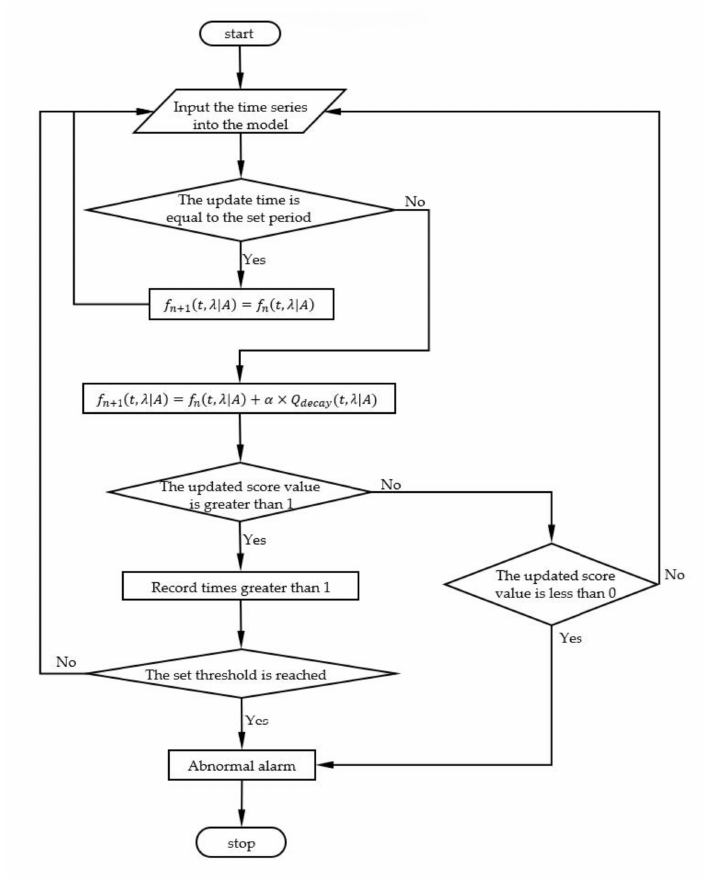
Figure 3. Flow chart of abnormal